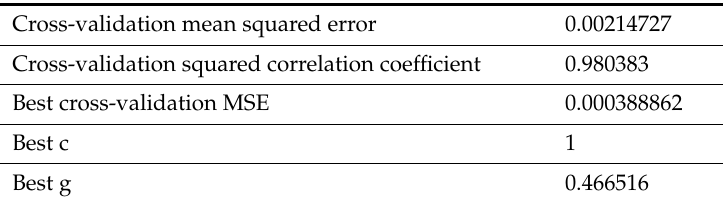
Table 4. Results of the fine